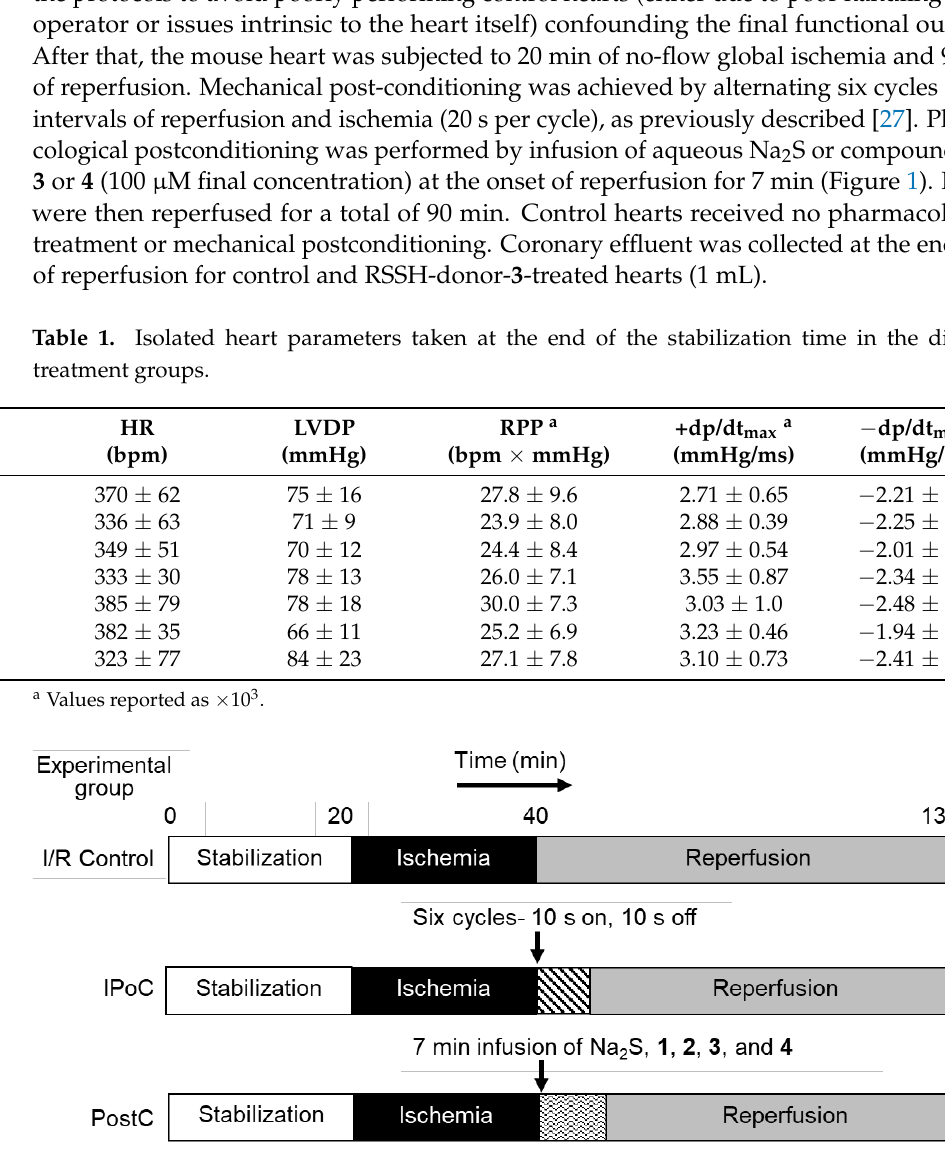
Figure 1. Schematic presentation of the Langendorff experimental protocol. Experimental groups: (1) I/R control, after equilibrium perfusion for 20 min, mouse hearts were subjected to 20 min of no-flow ischemia followed by 90 min reperfusion; (2) IPoC, after 20 min stabilization, mouse hearts were subjected to 20 min of no-flow global ischemia followed by alternating six cycles of 10-s intervals of reperfusion and ischemia and then reperfusion for 90 min; (3) PostC, after 20 min stabilization, mouse hearts were subjected to 20 min of no-flow global ischemia followed by infusion of 100 µ M of Na 2 S, donors 1 , 2 , 3 and 4 independently for 7 min and then reperfusion for 90 min. Abbreviations: IPoC: ischemic post-conditioning, PostC: pharmacological